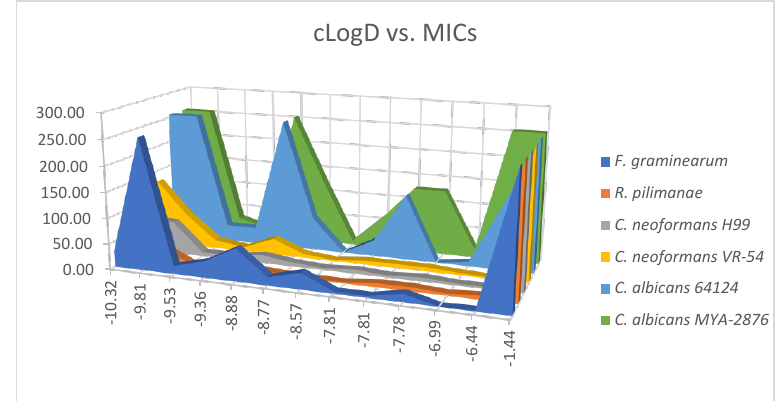
Figure 4. Relationship of the water/1-octanol distribution coefficient (cLogD) vs. minimal growth inhibitory concentration (MIC). Molecules 2019 , 24 , x FOR PEER REVIEW